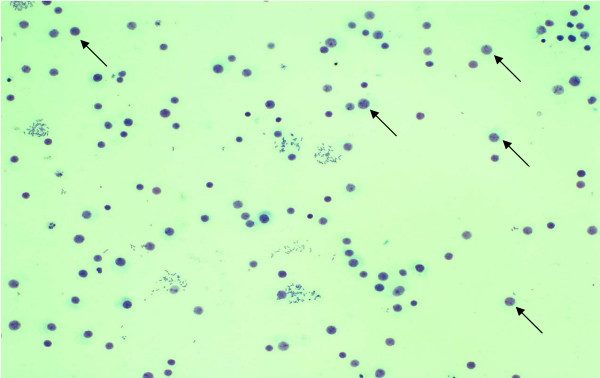
Lymphocyte proliferation in the control group. The black arrows indicated many living lymphocytes in this group.